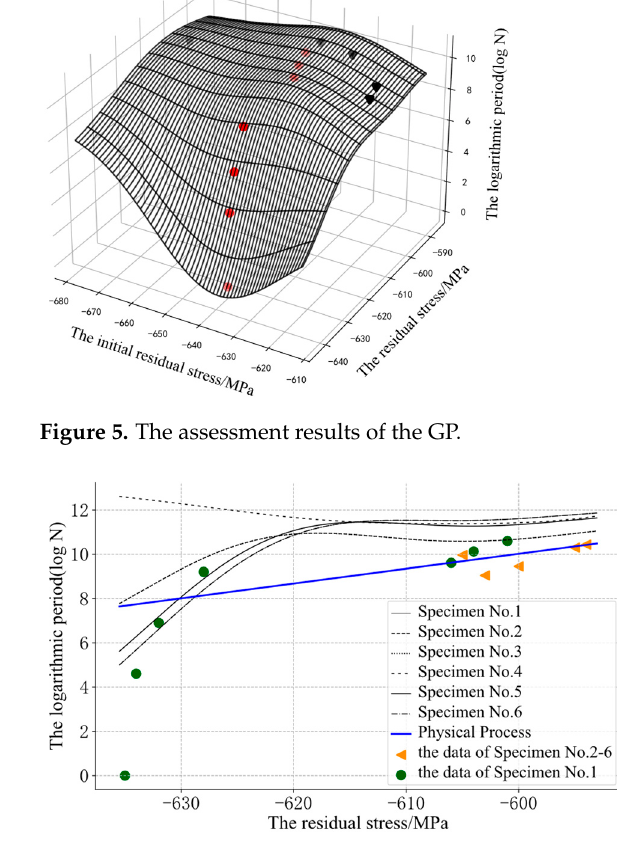
Figure 6. The assessment results of the GP: different line styles represent the fatigue relaxation process of different specimens. The triangle marks represent the data of specimens No. 2–6 and the circular mark represents the data of specimen No. 1.